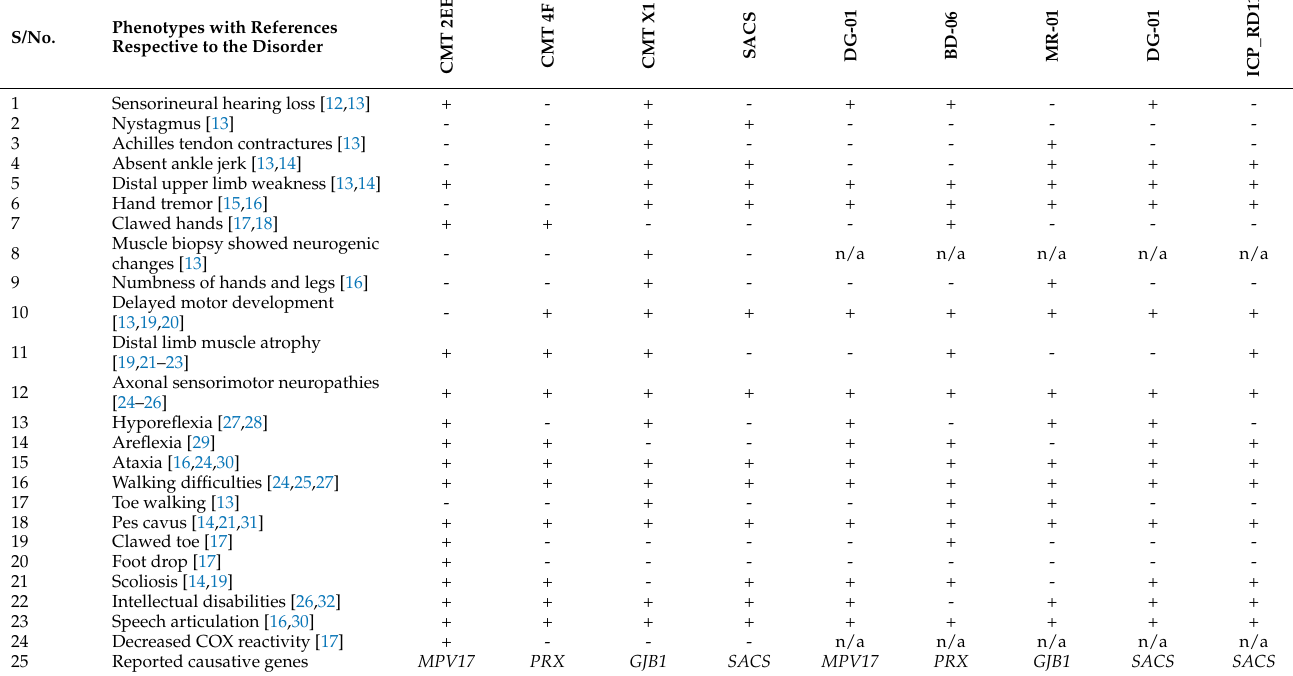
Table 1. Different phenotypes have been reported in literature related to three types of Charcot– Marie–Tooth disease and autosomal recessive spastic ataxia of Charlevoix–Saguenay type. These have been compared with the four gene mutations we have